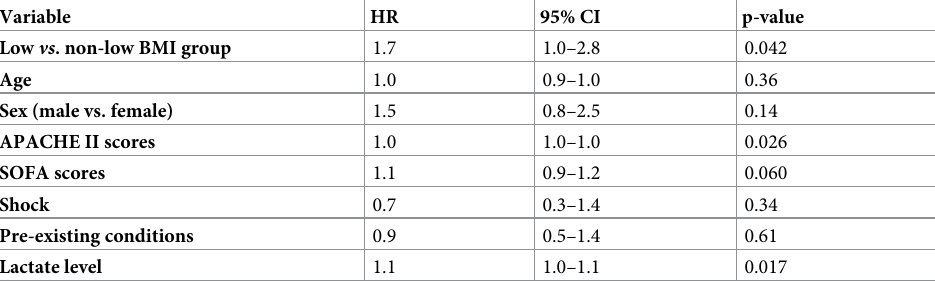
Table 6. Cox proportional hazards regression model for 28-day mortality.